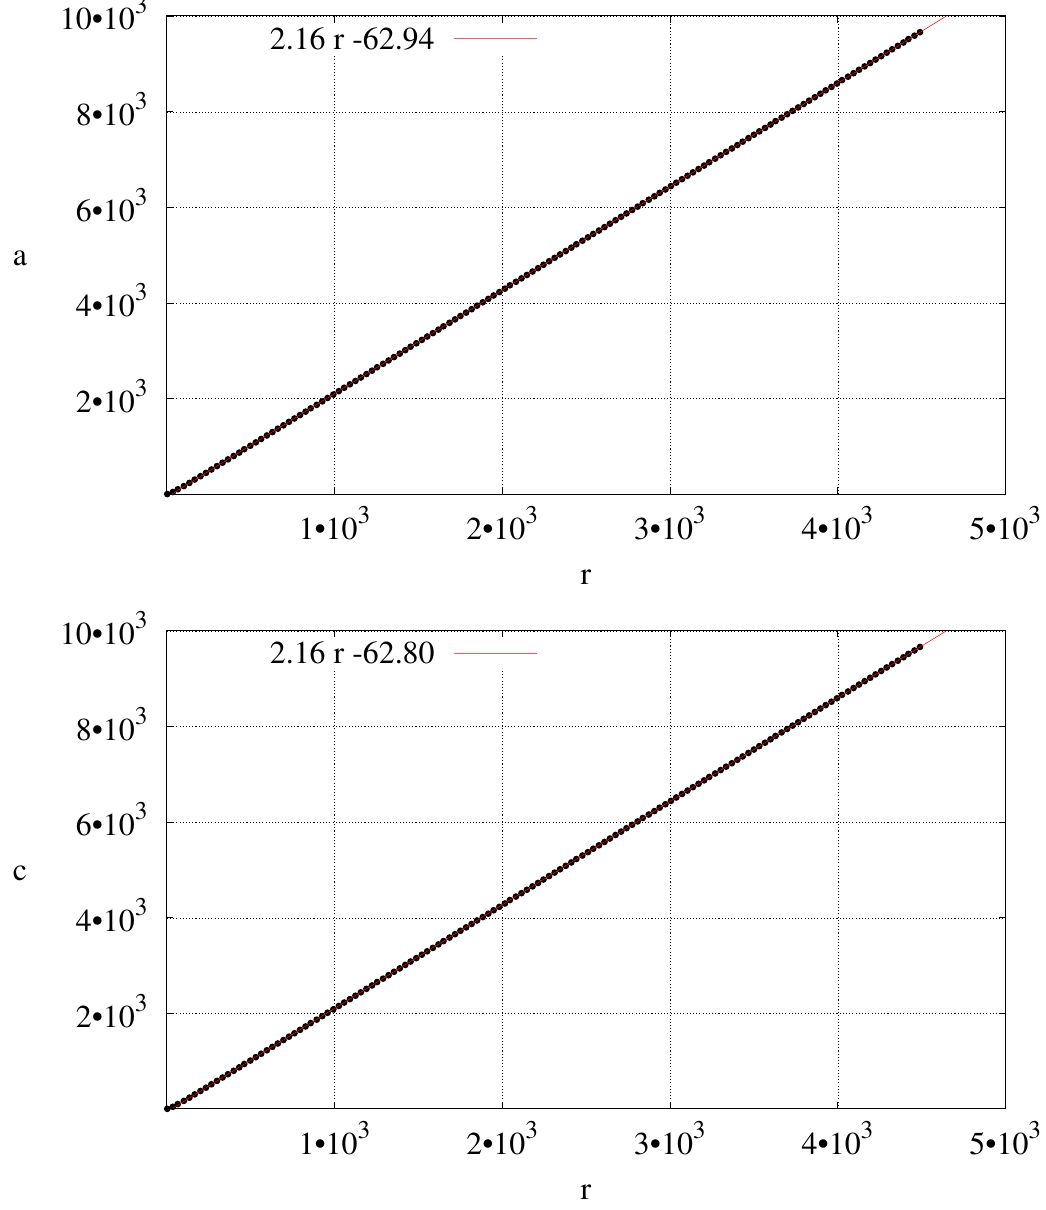
Figure 1 . We plot how the central charges scale with the rank for ( A m ; E 6 ) with m in [1 ; 1500].